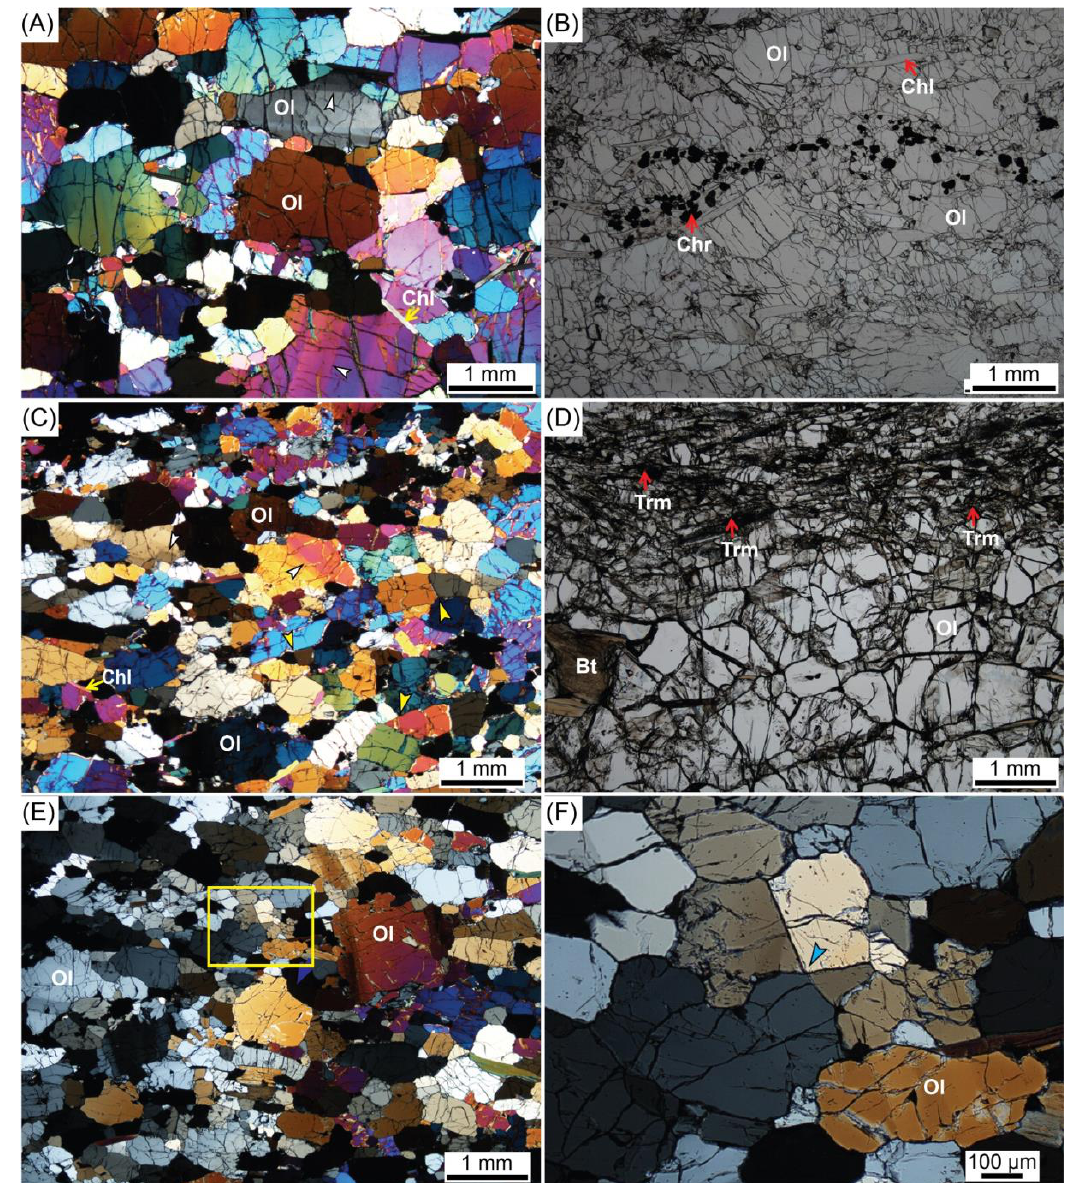
Figure 2. Optical photomicrographs of the samples in transmitted light. ( A ) Representative wide-view images of sample 448. White arrows mark the olivine crystals that show clear subgrain boundaries. Olivine and chlorite grain is indicated as Ol and Chl, respectively. ( B ) Spinel-rich layer observed in sample 429. Chromite and chlorite grains are indicated as Chr and Chl, respectively. ( C ) Representative wide-view images of sample 447. White arrows mark the olivine crystals showing clear subgrain boundaries. The yellow arrows mark the location of the tripple junctions. Olivine and chlorite grains are indicated as Ol and Chl, respectively. ( D ) Tremolite-rich layer observed from sample 443. Tremolite and biotite grains are indicated as Trm and Bt, respectively. ( E ) Wide view image of sample 447. The yellow rectangle indicates the location of Figure 2F. ( F ) Four-grain junction is observed in sample 447. The blue arrow marks the location of the four-grain junction.